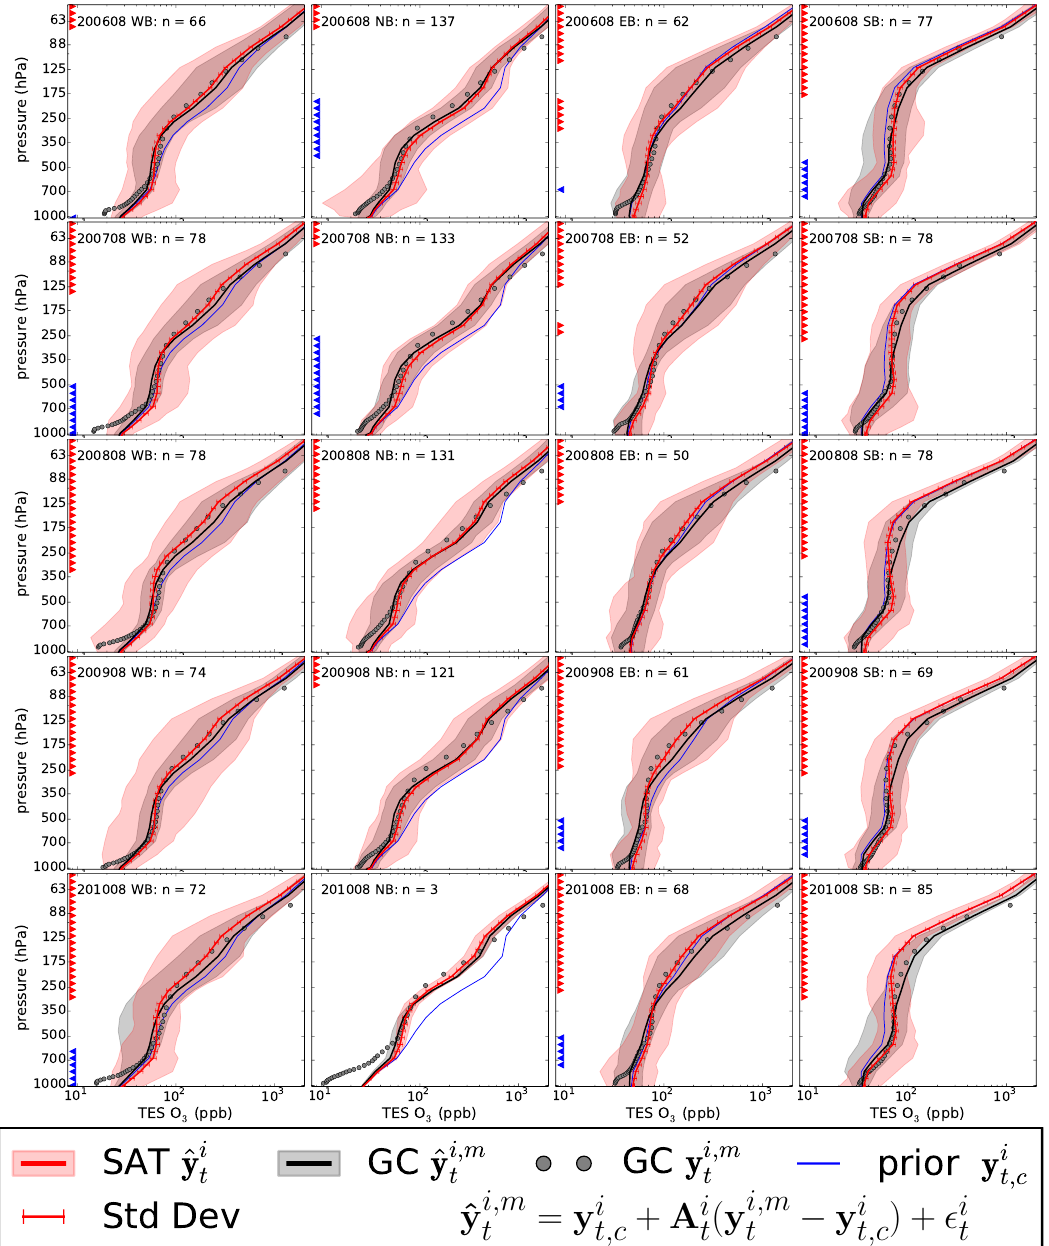
Fig. A2. Same as Fig. A1, but for August and includes year 2010.